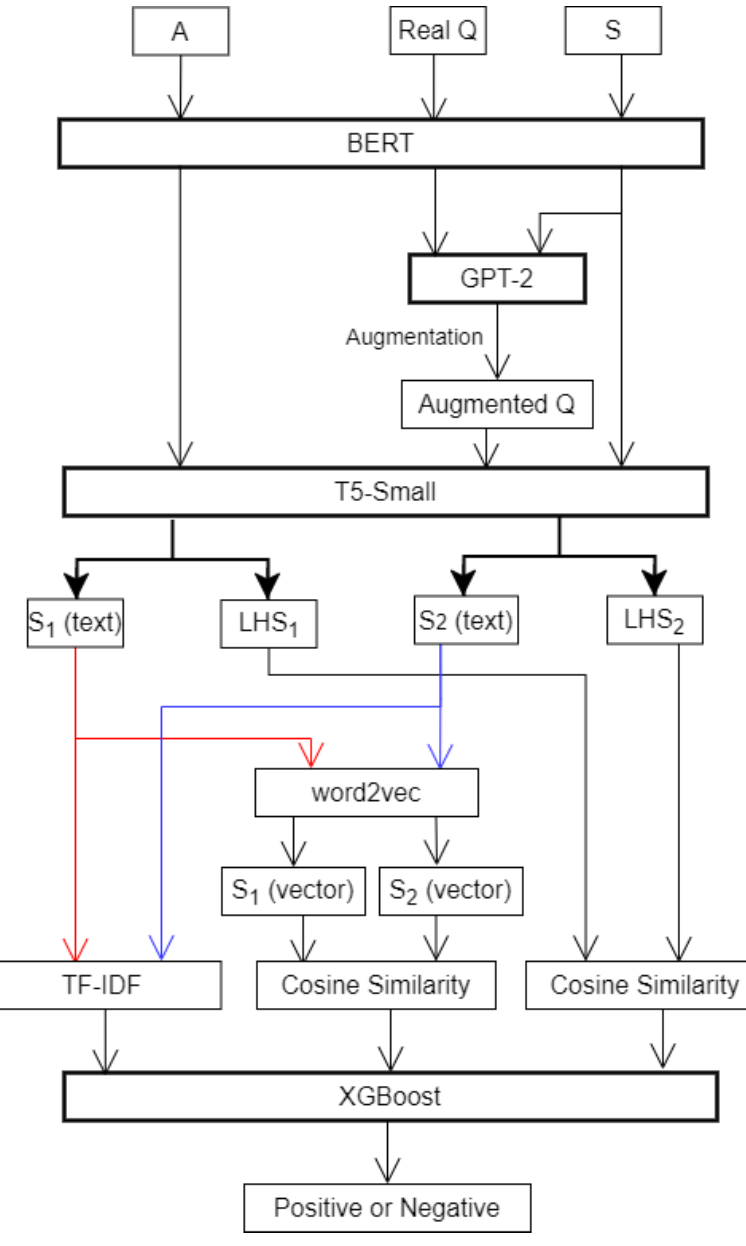
Figure 1. System